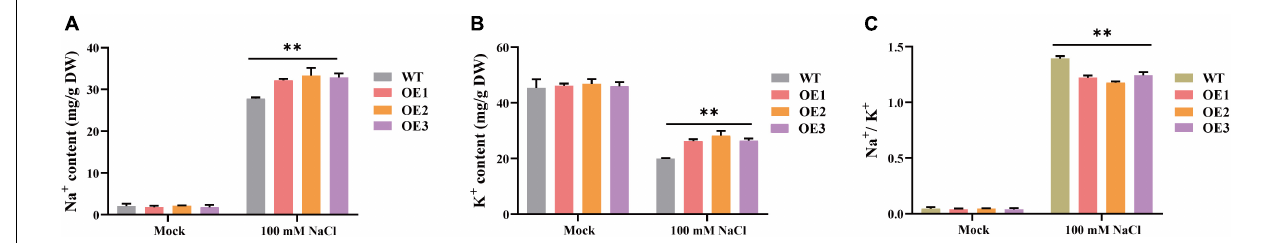
FIGURE 6 | Cation contents of wild-type (WT) and GhCLCg-1 -overexpressing transgenic Arabidopsis thaliana lines (OE1, OE2, and OE3). (A) Na + contents, (B) K + contents, and (C) Na + /K + ratio of A. thaliana under 0 mM or 100 mM NaCl treatment for 21 days. Data are presented as the mean ± standard deviation (SD) of three biological replicates ( ∗∗ p < 0.01, t -test).